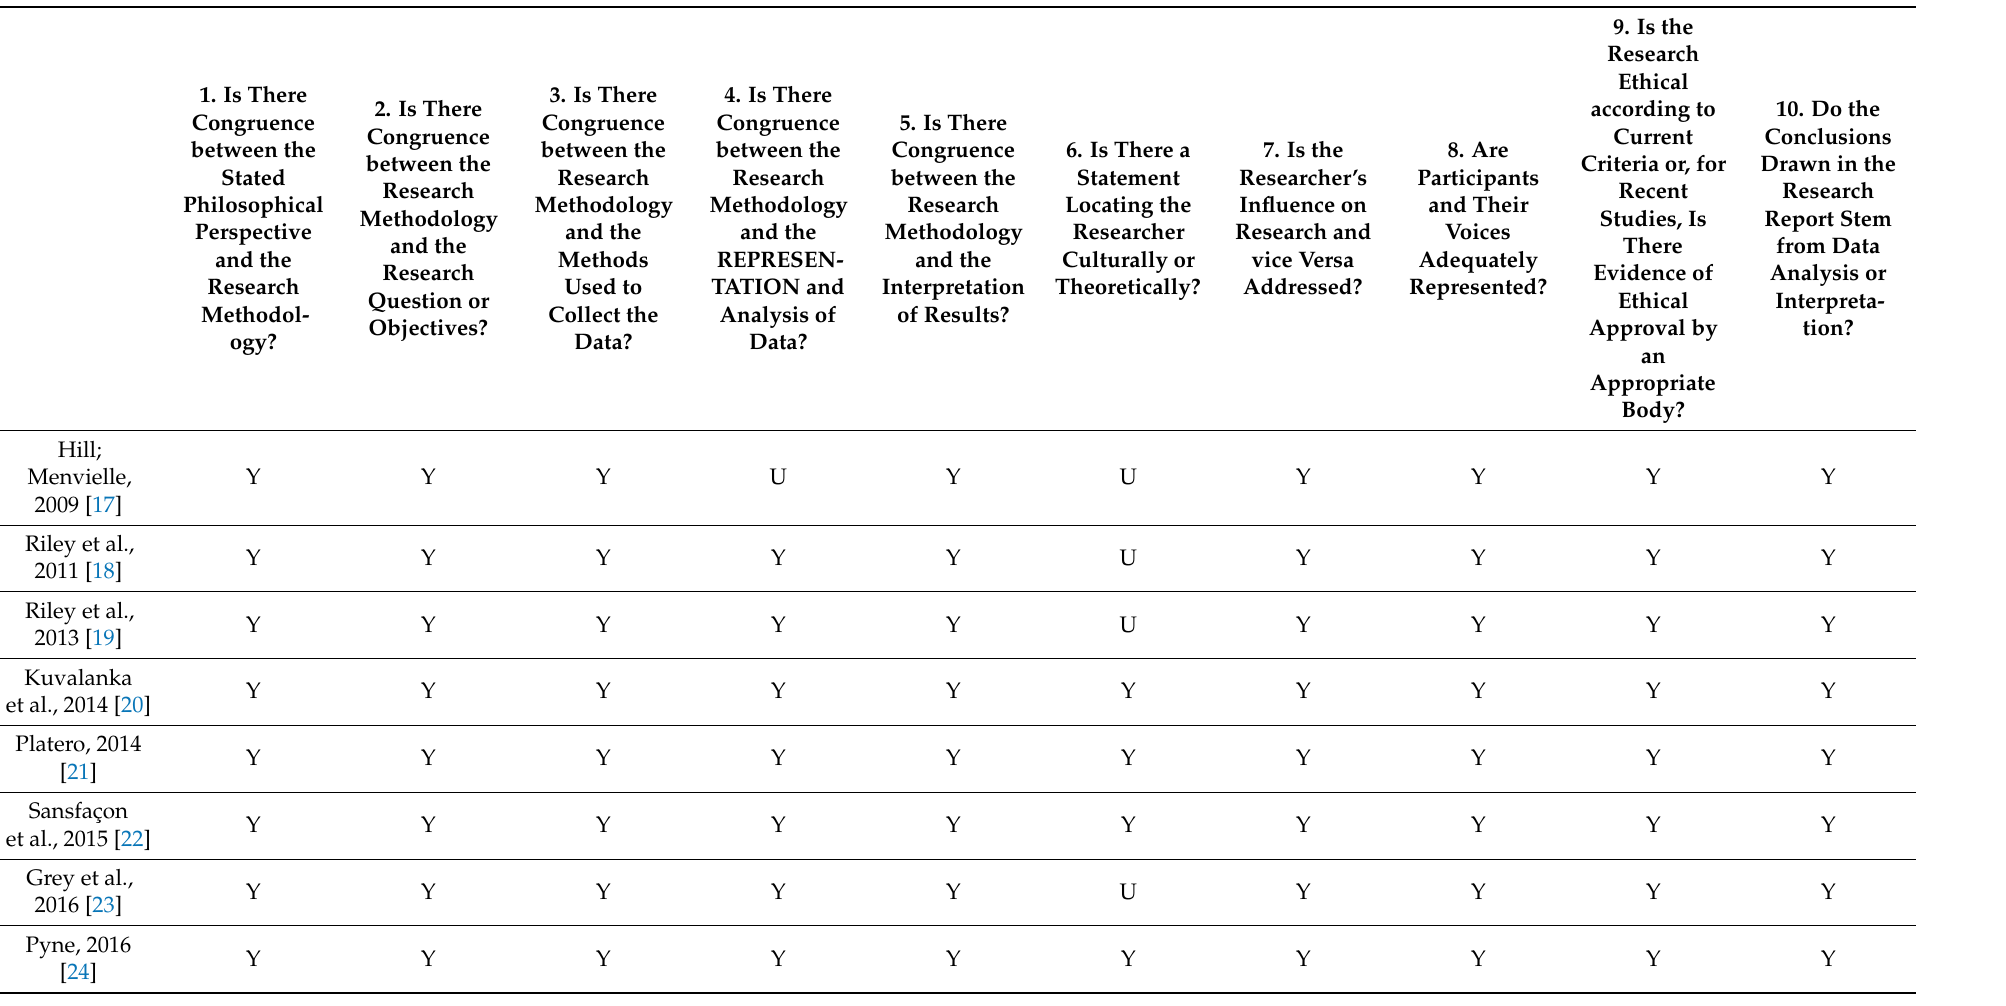
Table 2. Methodological quality of articles included in this systematic review on the dynamics of secondary social networks to support mothers, fathers, or guardians of transgender children and adolescents. Ribeirao Preto, SP, Brazil,